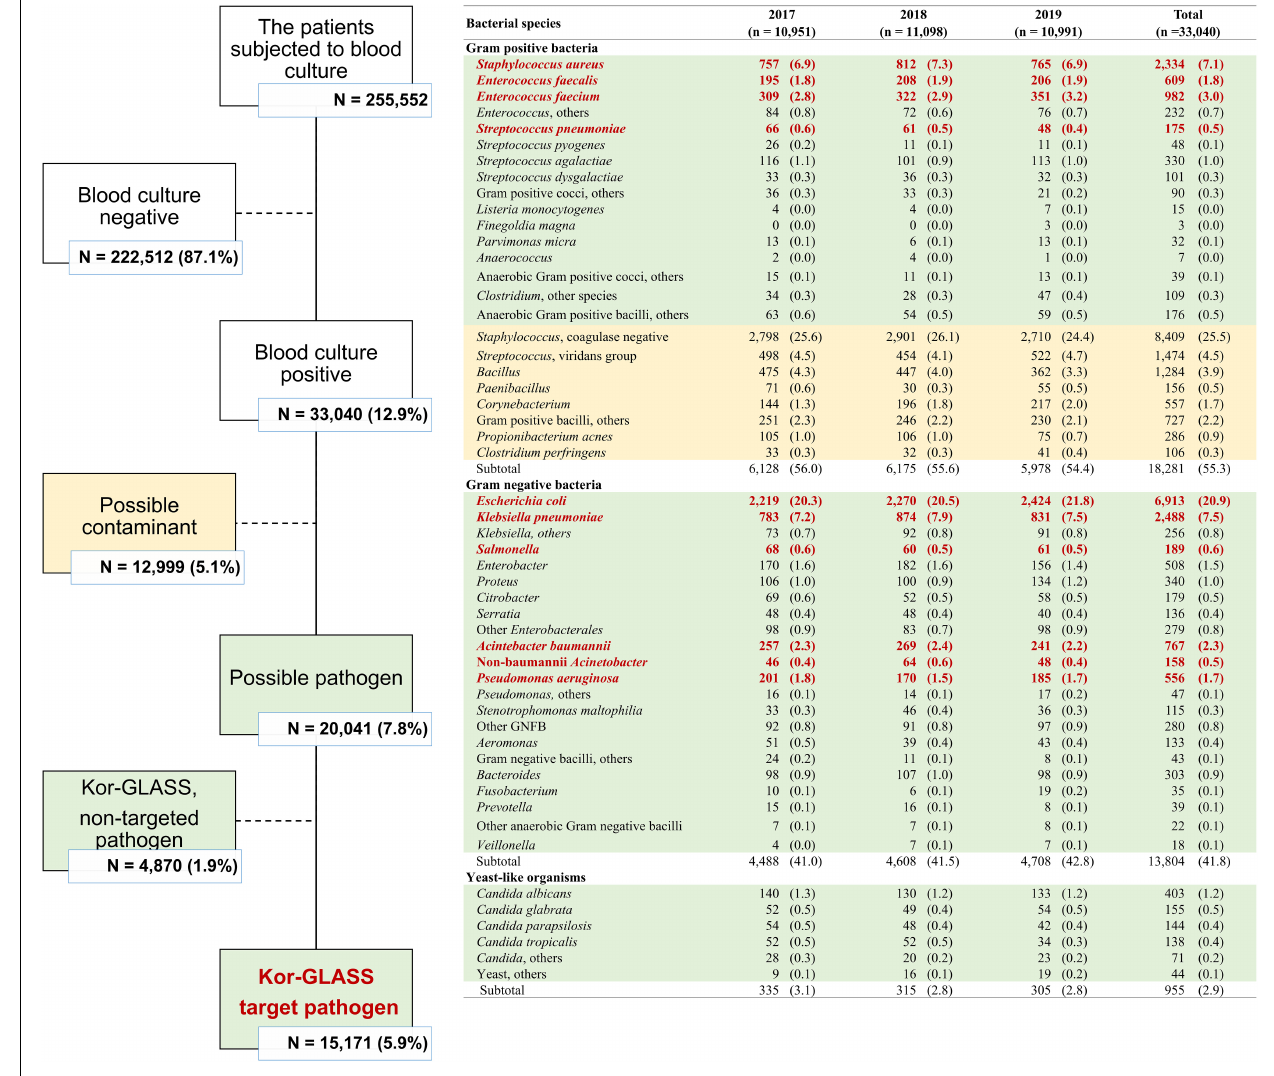
( n = 2,110), E. faecium ( n = 873), Acinetobacter spp. ( n = 607), E. faecalis ( n = 535), P. aeruginosa ( n =